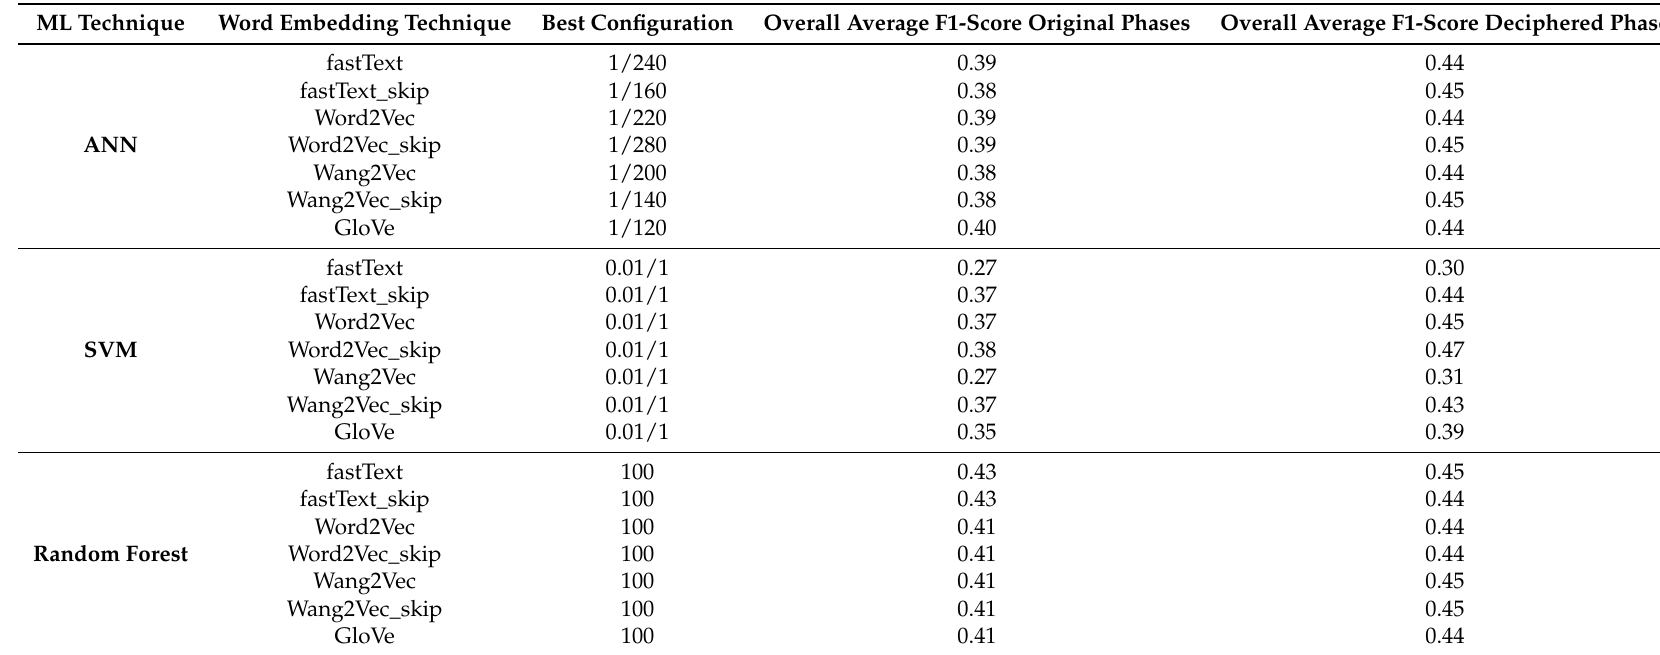
Table 2. Overall experimental results obtained with the ANN, SVM, and Random Forest classifiers. Word embedding vector dimension: 600. Cross-validation method with k =